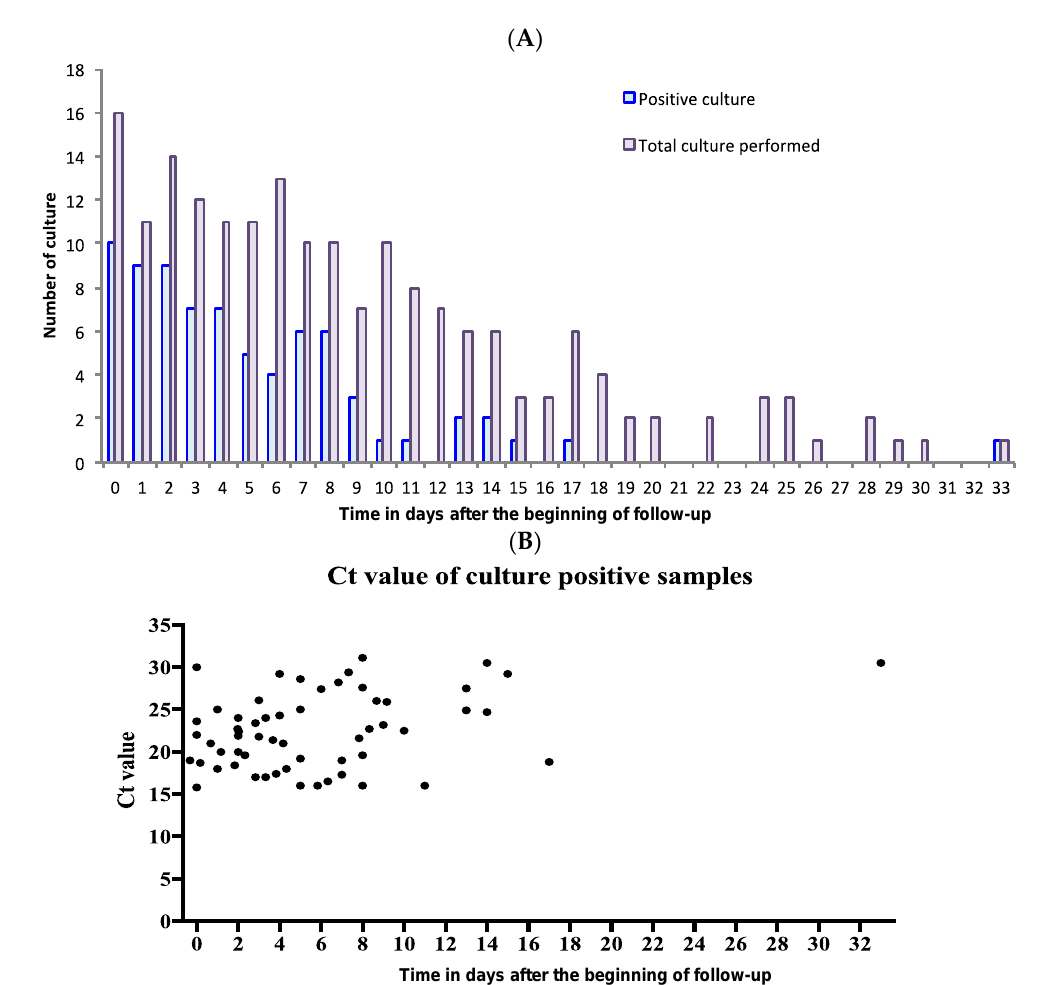
Figure 1. Culture results on 34 patients with persistent viral shedding (>17 days) . ( A ) Number of positive cultures for SARS-CoV-2 among the number of cultures performed . ( B ) SARS-CoV-2 cycle threshold values of samples with positive culture . Ct, cycle threshold value; 11 among the 69 samples had positive SARS-CoV-2 culture without Ct value.